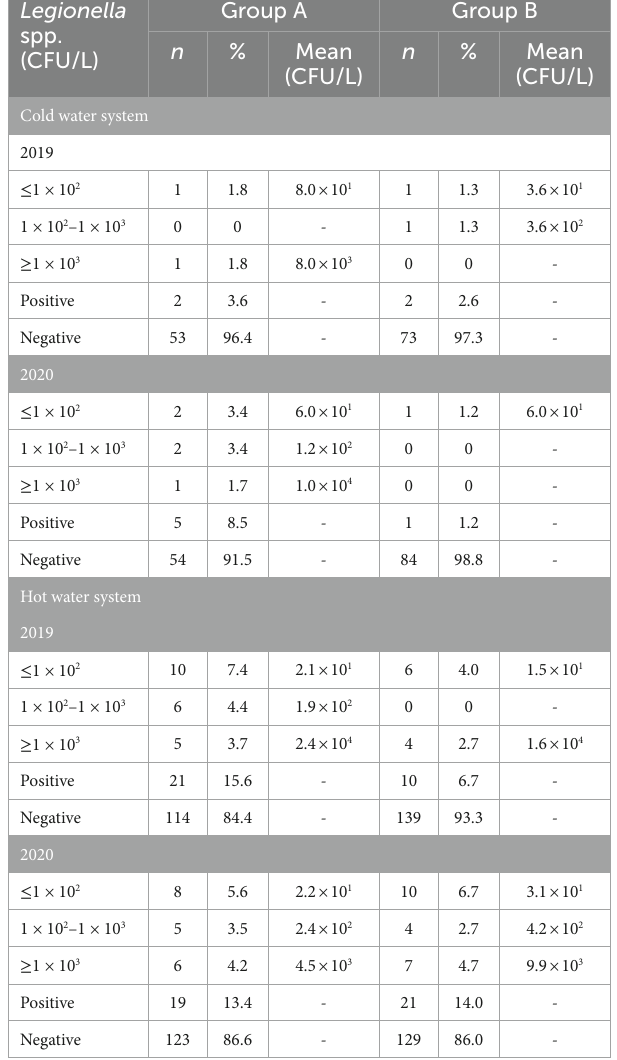
TABLE 3 Range of Legionella spp. concentrations by water system (cold and hot water systems), year (2019, 2020), and Group (A, B; n = number of samples, % = proportion of positive or negative samples, CFU/L = Colony Forming Unit per